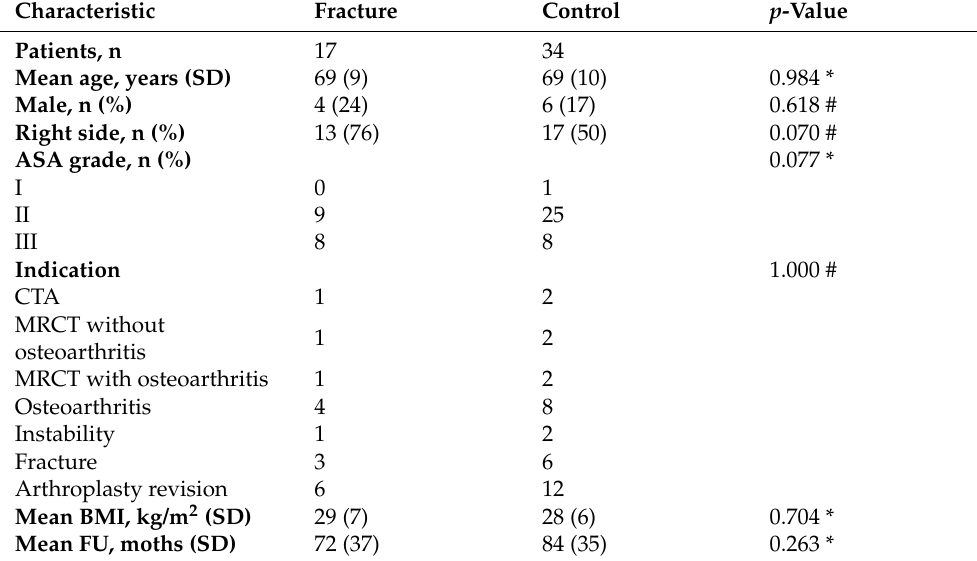
Table 1. Basic demographic and arthroplasty-related data. Mann-Whitney-U testing (*) and Chi square testing (#) were used to compare the groups. Abbreviations: ASA, American Society of